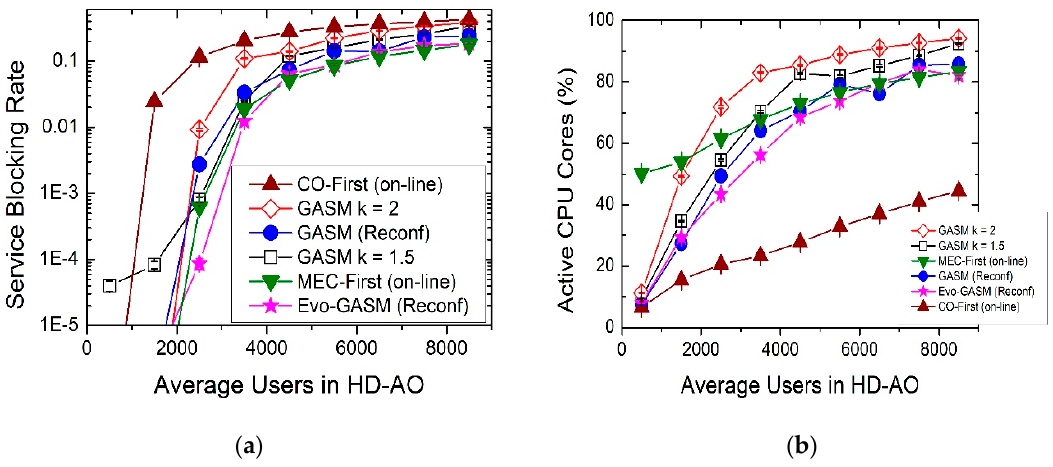
Figure 6. ( a ) Service blocking rate and ( b ) Percentage of the CPU Cores in use for the proposed methods. The results obtained when reconfiguration and online is performed are indicated with full symbols.